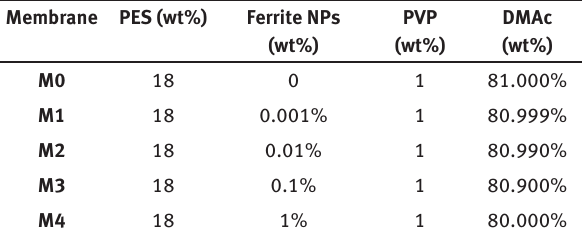
Table 3: The composition of materials in the membrane preparation Membrane PES